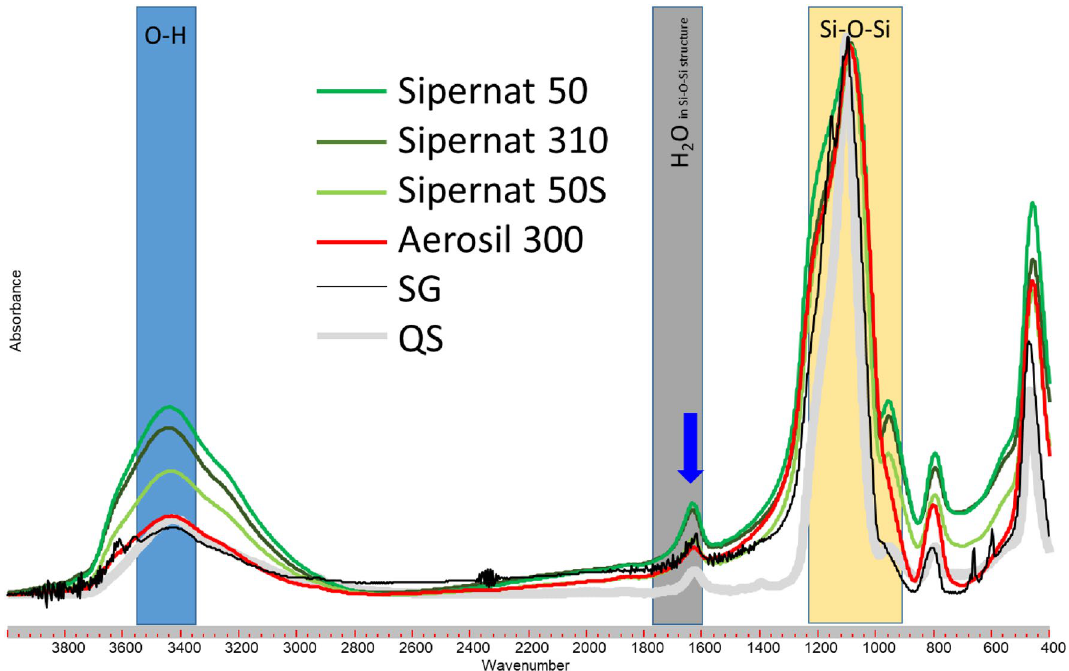
Figure 1. FTIR spectra of Sipernat 50, Sipernat 320, Sipernat 50S (each of them a precipitated silica; Evonik), ZEOfree 600 (ZEOfree, a precipitated Ca-silicate; Evonik), Aerosil 300 (Aerosil, a pyrogenic silica; Evonik), finely ground silica gel for chromatographic purposes (SG; Merck) and quartz sand < 63 µm (QS,